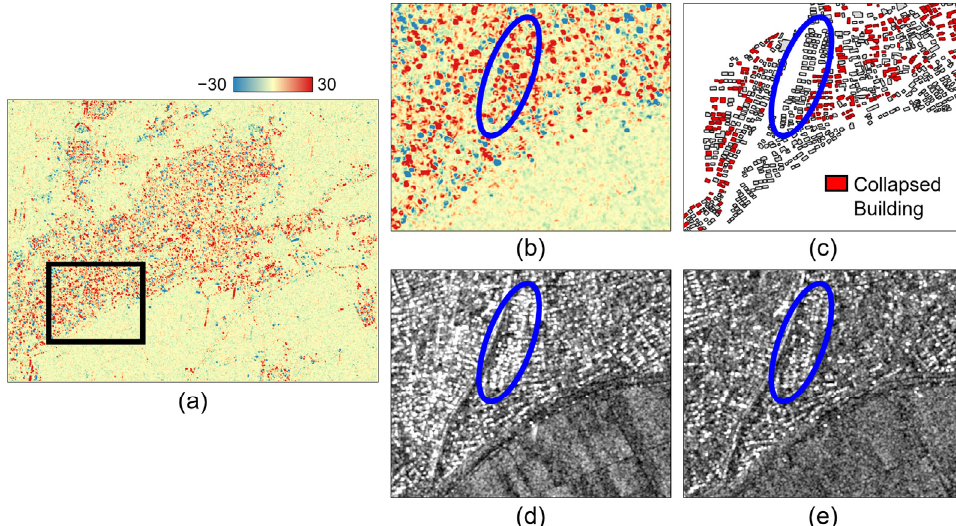
Figure 3. The GLCM-based damage index of ( a ) the whole study area, and ( b ) a zoomed area. The blue circle in the zoom areas illustrates undamaged areas with high values in the GLCM-based damage index. ( c ) The reference damage map and the original SAR intensity of ( d ) pre-seismic and ( e ) post-seismic data for a zoom area.